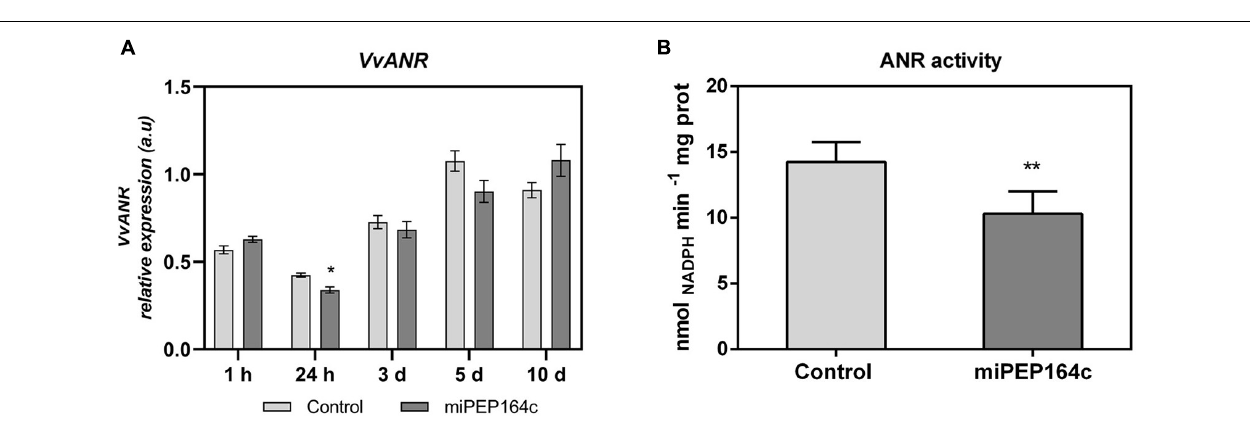
FIGURE 4 | Steady-state transcript levels of VvANR in suspension-cultured grape berry cells (cv. Gamay) 10-day after elicitation with various concentrations of miPEP164c (A) and the effect on the specific activity of anthocyanidin reductase (ANR) (B) in suspension-cultured grape berry cells (cv. Gamay) after 10 days of elicitation with 1 µ M miPEP164c. Gene expression analysis, by real-time qPCR was normalized with the expression of reference gene VvACT1 and VvGAPDH . Values are the mean ± SEM. Asterisks indicate statistical significance in relation to the control (Student’s t -test; * P < 0.05). ANR biochemical activity represented as the V max in grape berry cells under miPEP164c treatment. Values are the mean ± SEM. Asterisks indicates statistical significance (Student’s t -test; ** P <